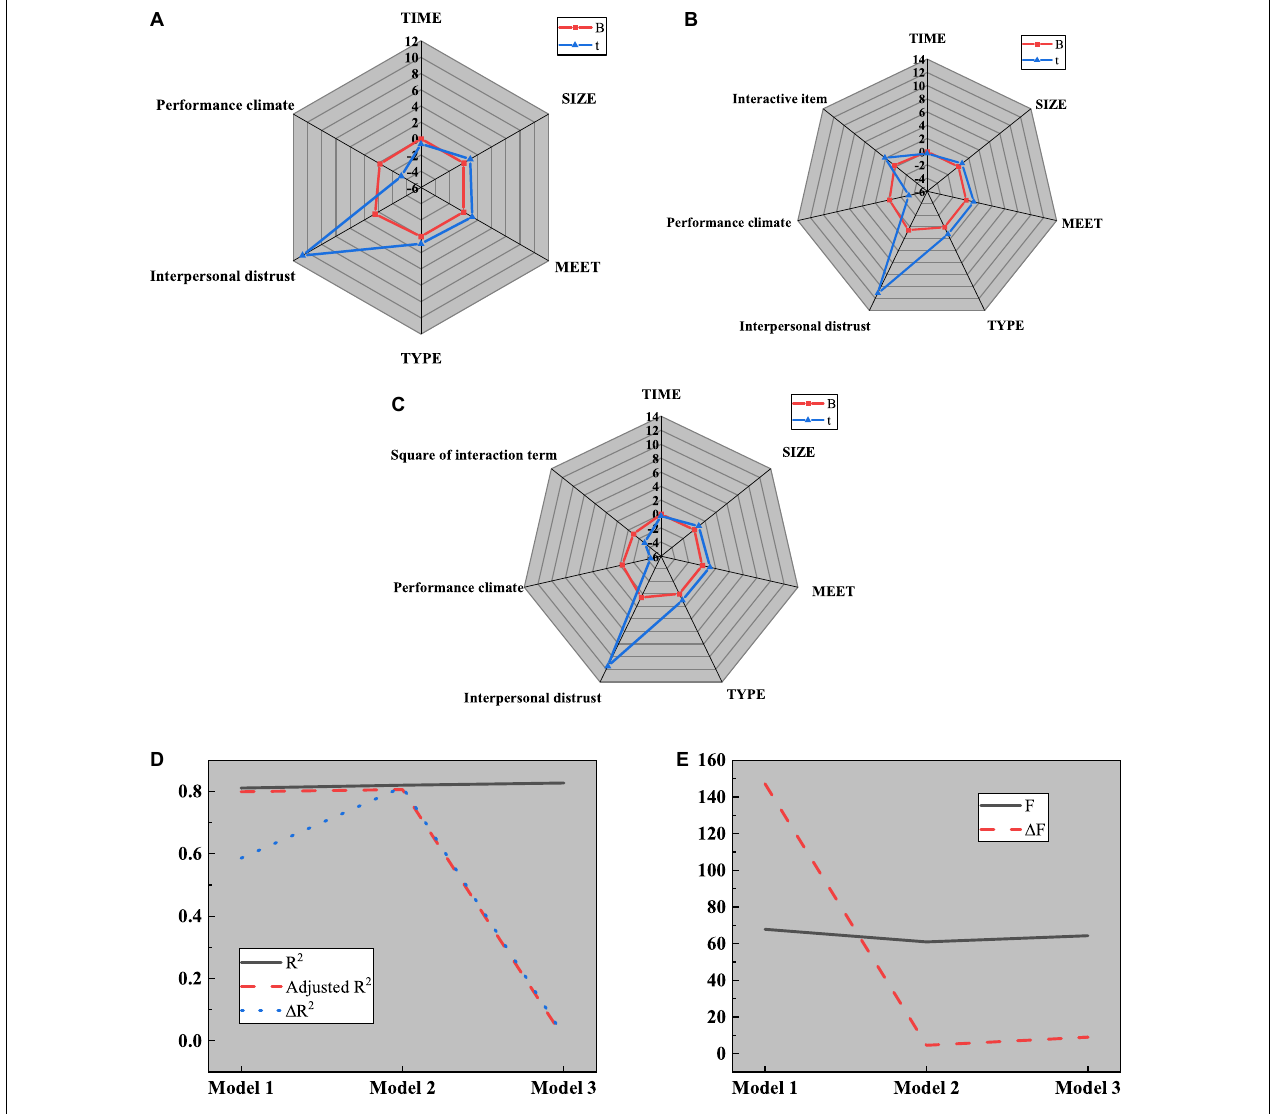
FIGURE 16 | Test of the mediating effect of performance atmosphere on interpersonal mistrust and temporary team performance. (A) Regression model 1; (B) Regression model 2; (C) Regression model 3; (D) Parameters of R 2 ; (E) Parameters of F.